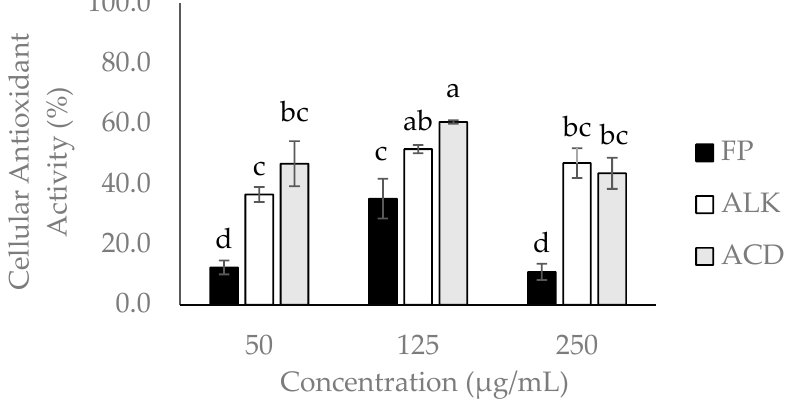
Figure 2. Cellular antioxidant activity (CAA) of the free phenolic (FP), alkaline (ALK), and acid (ACD) fractions obtained from mango cv. Ataulfo peel. Caco-2 cells were treated with 50, 125, and 250 µg/mL of each fraction for 20 min. Value are presented as mean ± standard deviation; a, b, c, d different letters above the bars indicate significant differences in the PC content between mango peel fractions ( p < 0.05).